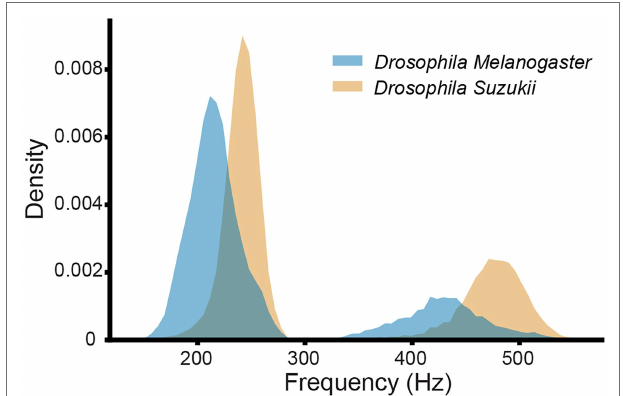
FIGURE 4 | Histograms of the main wingbeat frequencies and the first harmonics of D. melanogaster and D. suzukii wingbeat signals from the controlled